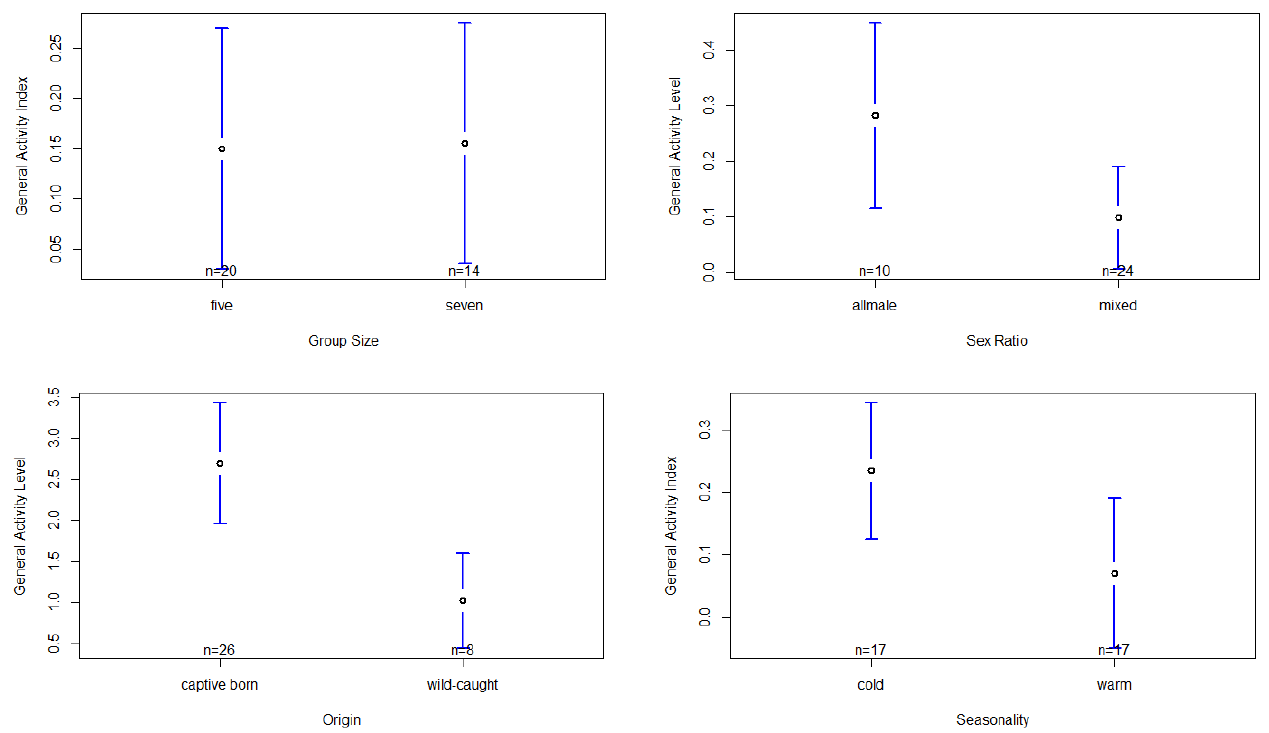
Figure 3. Confidence interval plots of the general activity levels and all significant fixed factors (size, sex ratio, origin, seasonality).